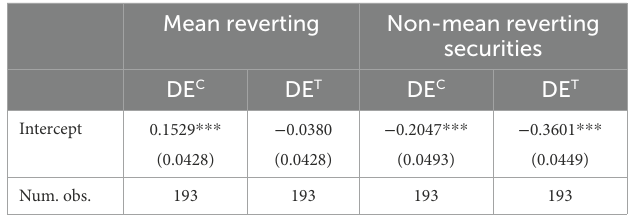
Table 3 documents sub-group analysis by gender and tenure.